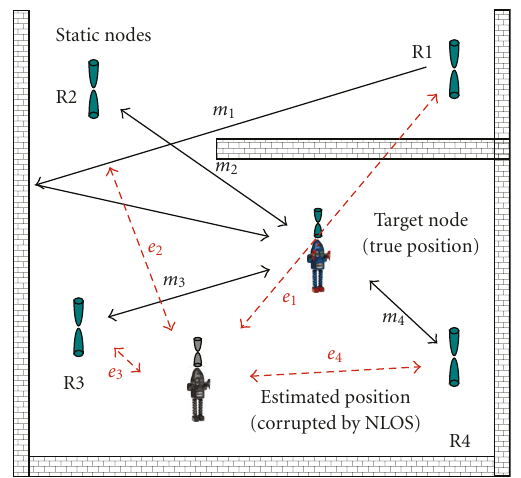
Figure 1: Example location scenario. The network consists of four static reference nodes R1–R4 (indicated by receiving antenna in green/black) and one target node T1 (indicated by a robot with transmitting antenna). The blockage by the wall between Node R1 and T1 creates an NLOS situation, but for the others reference nodes, T1 is in an LOS position. The m i ( i = 1,2,3,4) are the range estimates between the reference nodes and the target